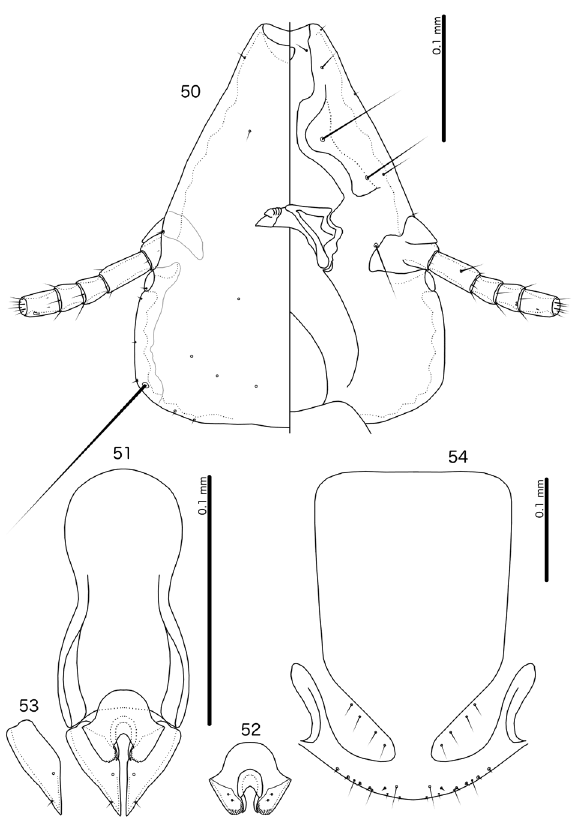
Figures 50–54. Brueelia kratochvili Balát, 1958, ex Motacilla flava Linnaeus, 1758 50 Male head, dorsal and ventral views 51 Male genitalia, dorsal view 52 Male mesosome, ventral view 53 Male paramere, dorsal view 54 Female subgenital plate and vulval margin, ventral